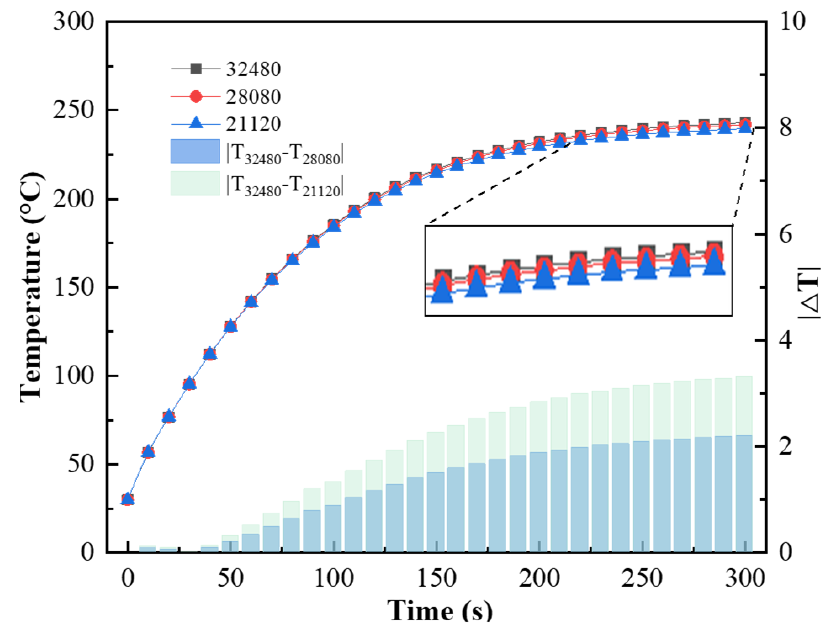
Figure 17. Coating temperature versus time with different grid sizes.